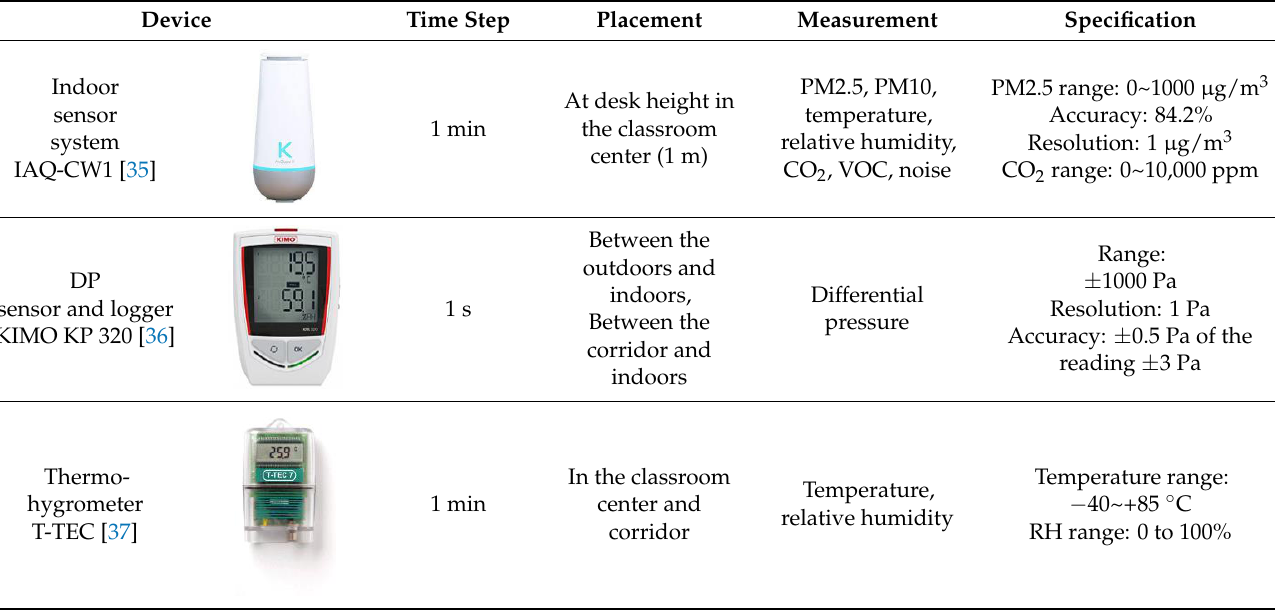
Table 2. Specification of measurement devices.